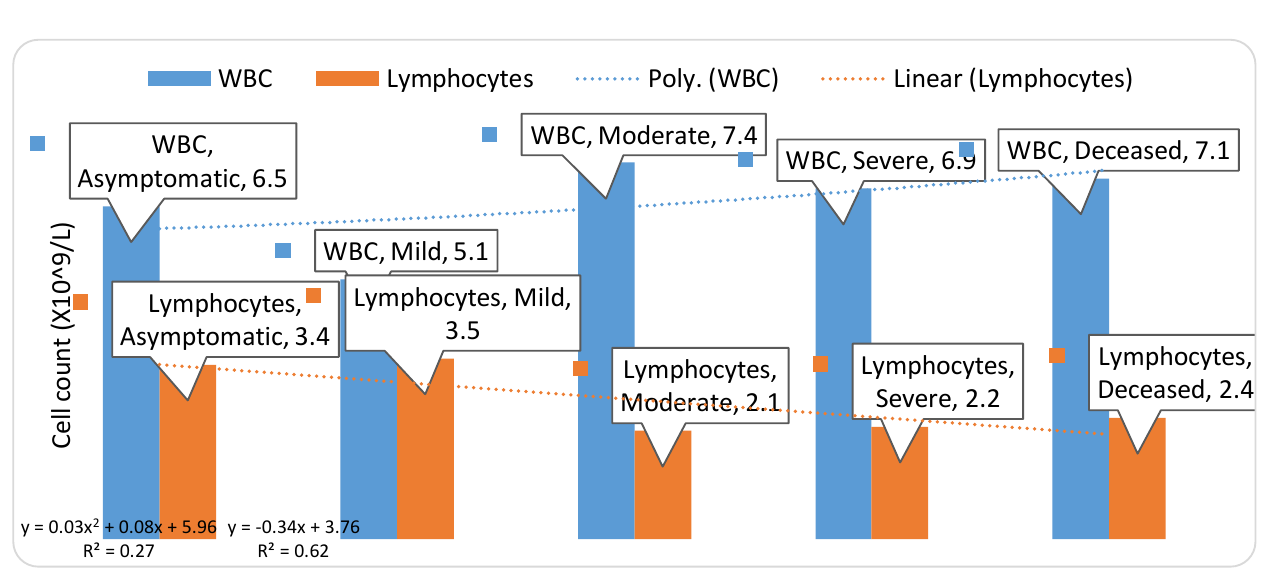
Figure 6: WBC & lymphocyte counts among 100 patients with COVID-19 of different